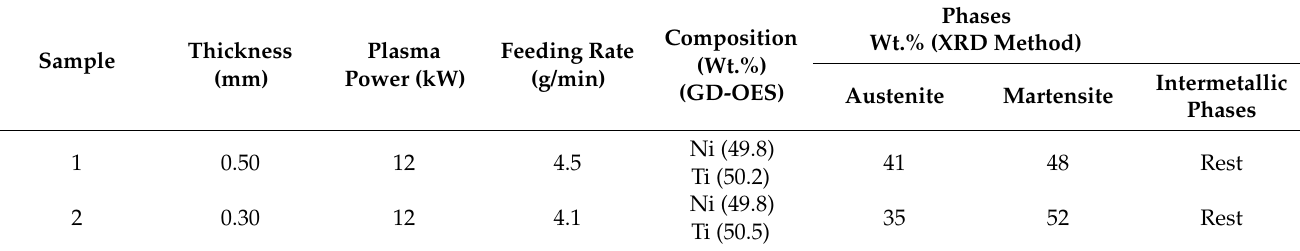
Table 1. Sample prepared by plasma spraying with chemical composition and phase analysis.